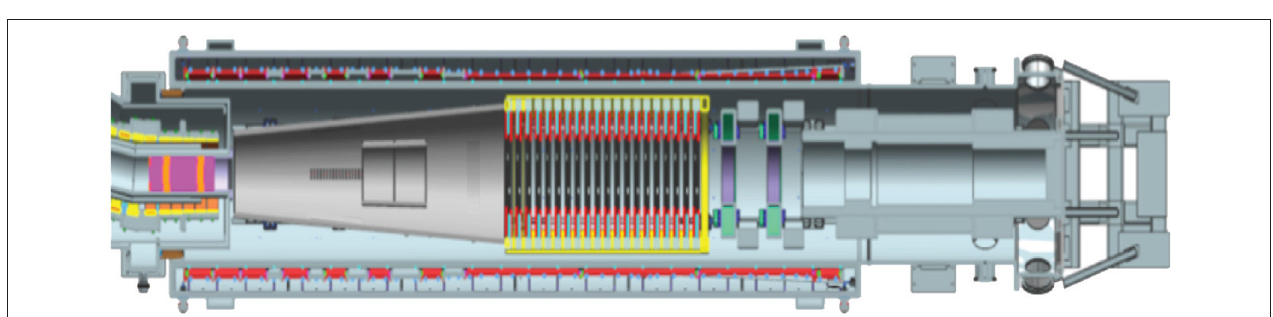
FIGURE 10 | Cutaway view of detector. The stopping target and its surrounding polyethylene absorbers are on the left. The tracker follows, with the two disks of the calorimeter to the right. A muon beam stop is indicated after the calorimeter, and the solenoid endcap is to the right. The detector elements and beam stop are placed on rails so that they can be assembled externally to, or removed from, the detector solenoid. Figure courtesy of the Mu2e collaboration.